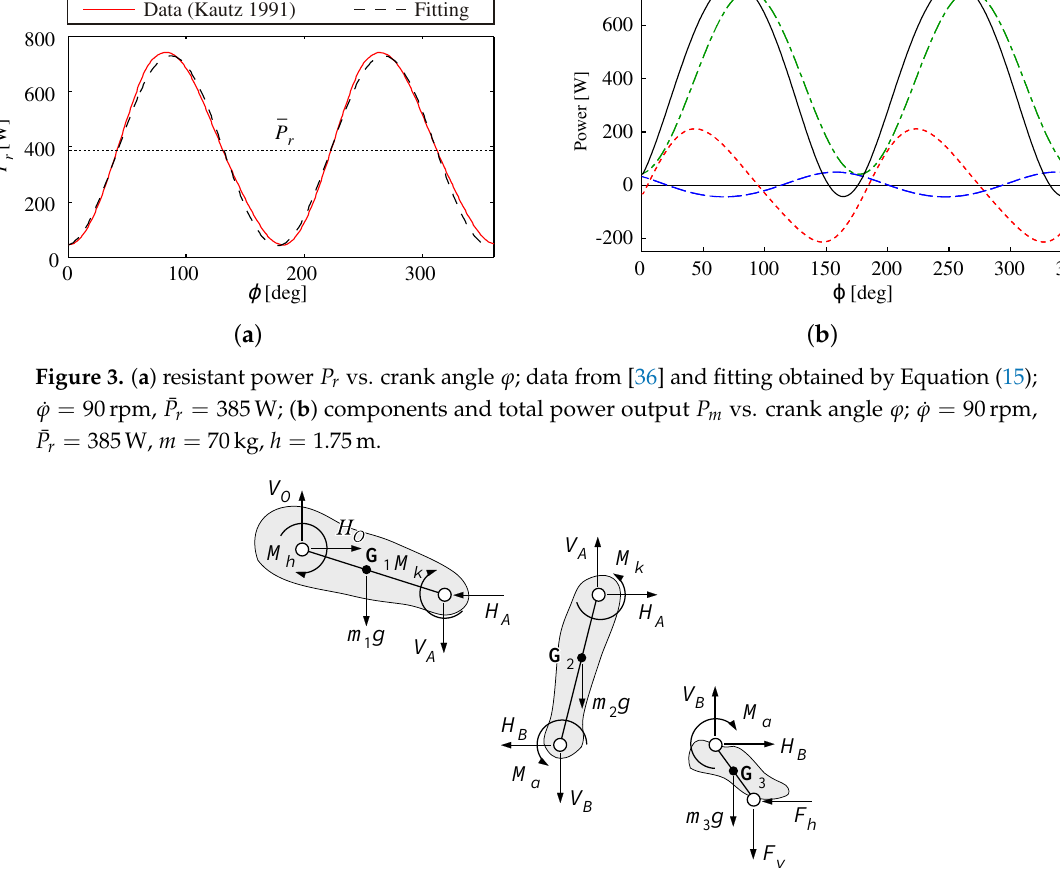
Figure 4. Free body diagram for the Newton–Euler formulation.